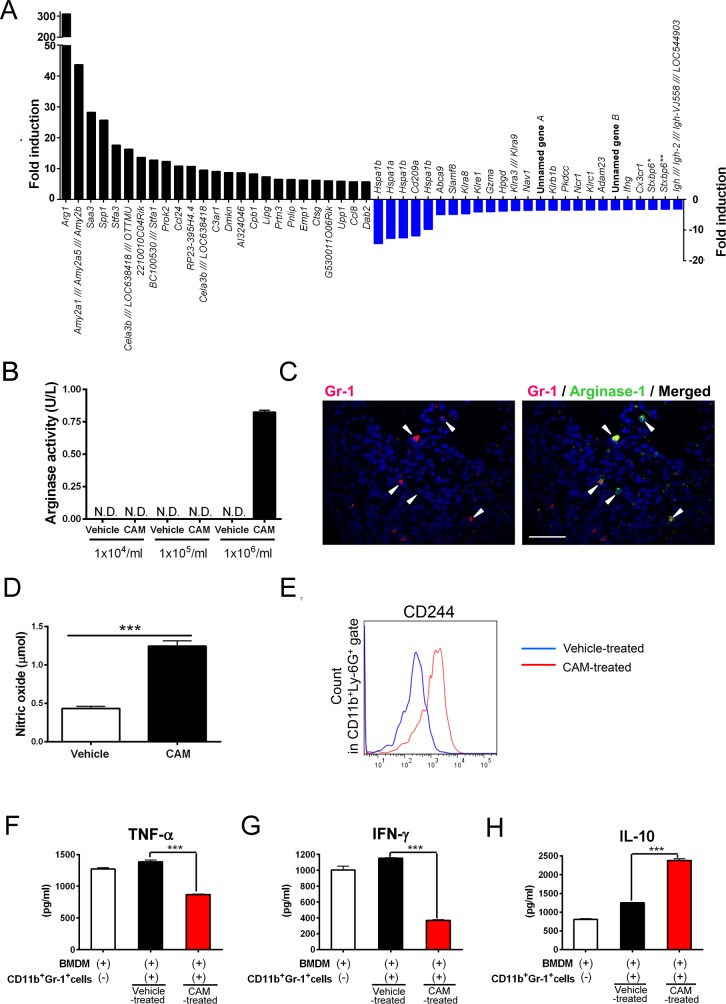
CAM-treated CD11b+Gr-1+ cells exhibit an immunosuppressive phenotype.(A) Top 25 upregulated and downregulated genes determined by a microarray analysis in splenic CD11b+Gr-1+ cells sorted from vehicle- and CAM-treated mice. *Stxbp6 (chromosome 12:45956210–46175345). **Stxbp6 (chromosome 12:45953470–45956090). Results are presented as fold changes relative to the expression levels of each gene in vehicle-treated CD11b+Gr-1+ cells. (B) Arginase activity in the spleen of vehicle- and CAM-treated mice (n = 4 per group). N.D., not detected. (C) Immunofluorescence staining of Gr-1 and arginase-1 in the lungs of mice treated with CAM daily for three consecutive days (n = 4 per group). Scale bar, 200 μm. (D) The concentration of nitric oxide (NO) in spleen extracts of vehicle- and CAM-treated mice (n = 4 per group) ***p < 0.001 by the Mann–Whitney U-test. (E) Expression of the surface marker CD244 on splenic CD11b+Ly-6G+ cells determined by flow cytometry (n = 4 per group). (F–H) Cytokine profile of the culture supernatant from bone marrow-derived macrophages (BMDMs) with or without equal numbers of vehicle-treated or CAM-treated CD11b+Gr-1+ cells (5 × 105 cells) in the spleen: TNF-α (F), IFN-γ (G), and IL-10 (H). Representative data for three independent experiments are shown. Data are expressed as the mean ± SEM. ***p < 0.001 by a one-way ANOVA with Tukey’s multiple comparison tests.